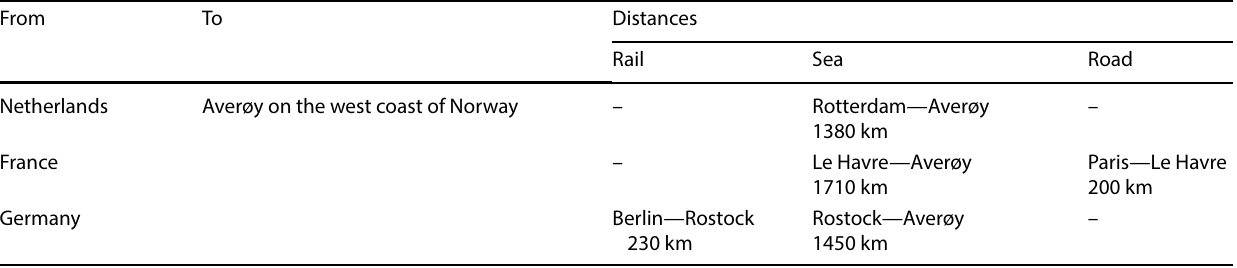
Table 3 Distances and means of transportation for insect meal delivered to the west coast of Norway (assumptions, based on Google maps and sea-distances.org) From